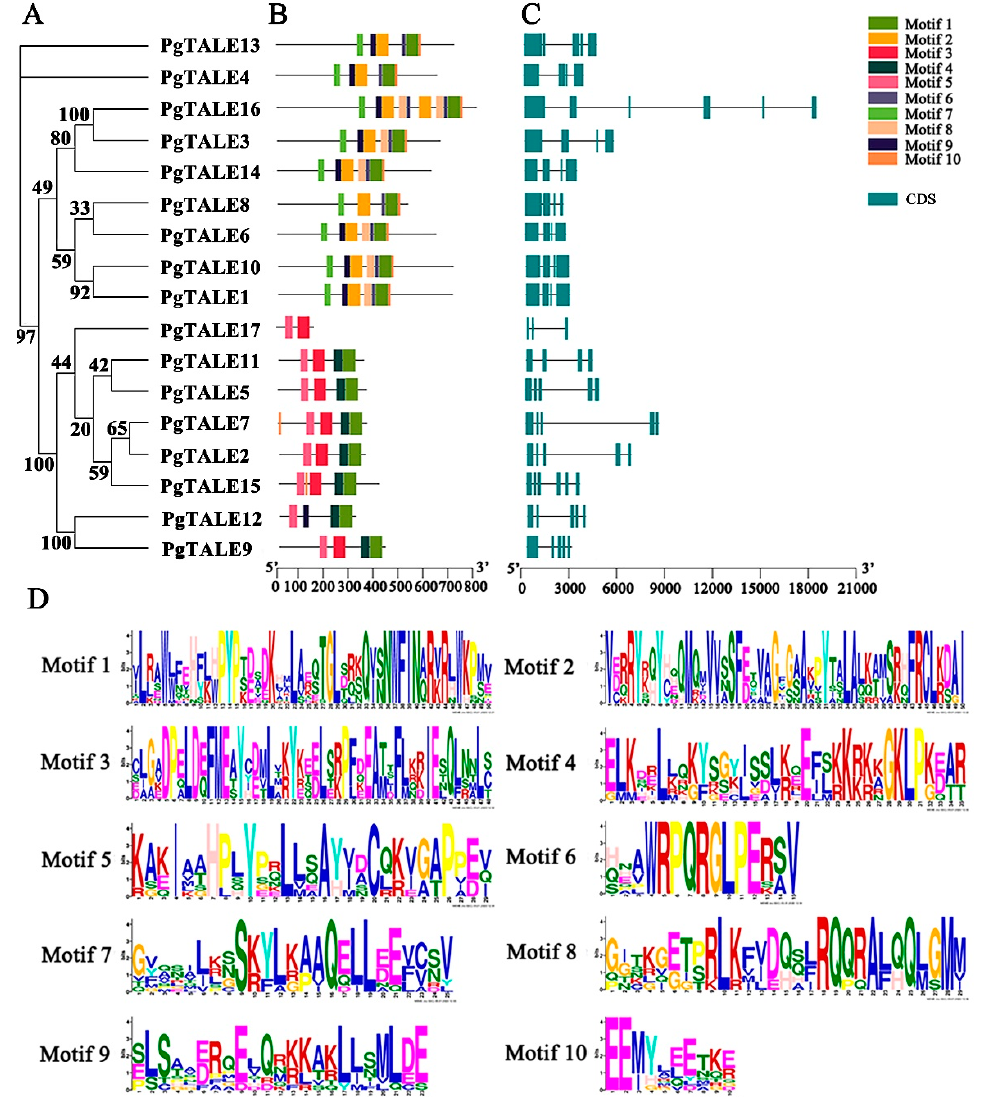
Figure 2. Phylogenetic tree, conserved motifs and gene structures of the PgTALE gene family. ( A ) The phylogenetic tree of 17 PgTALE proteins. ( B ) Conserved motifs in the TALE proteins. The motifs were identified by the MEME Suite. Di ff erent conserved motifs, numbers 1–10, are displayed in di ff erent colored boxes. ( C ) Gene structures of the TALE genes. The intron / exon structure was mapped by TBtools. The black dotted line represents introns. ( D ) Sequence logos of 10 conserved motifs were identified.